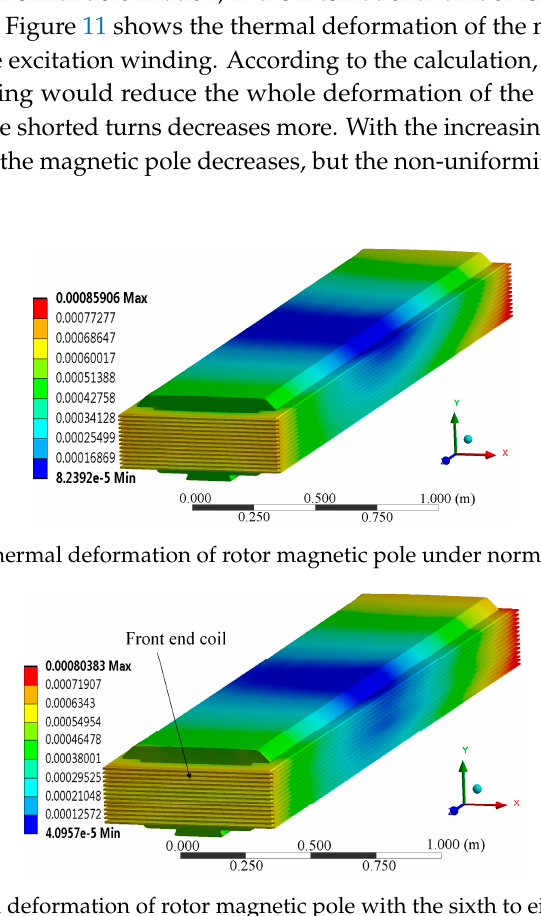
Figure 11. Thermal deformation of rotor magnetic pole with the sixth to eighth turns shorted.